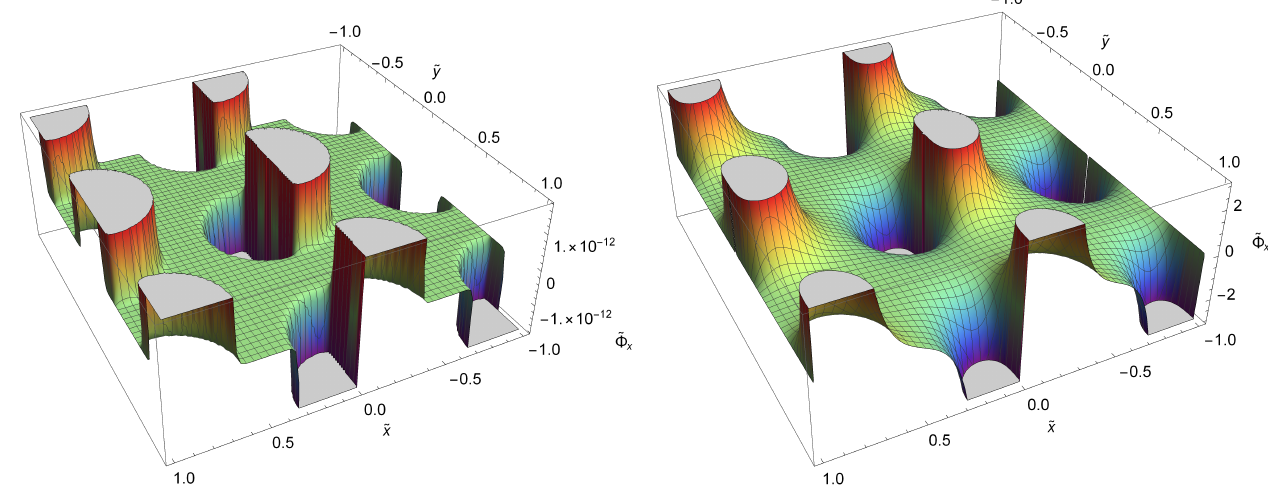
Figure 3. x -component of the force, ˜ Φ x ≡ ∂ ˜ Φ / ∂ ˜ x , for ˜ λ eff = 0.01 ( left panel ) and ˜ λ eff = 0.1 ( right panel ).